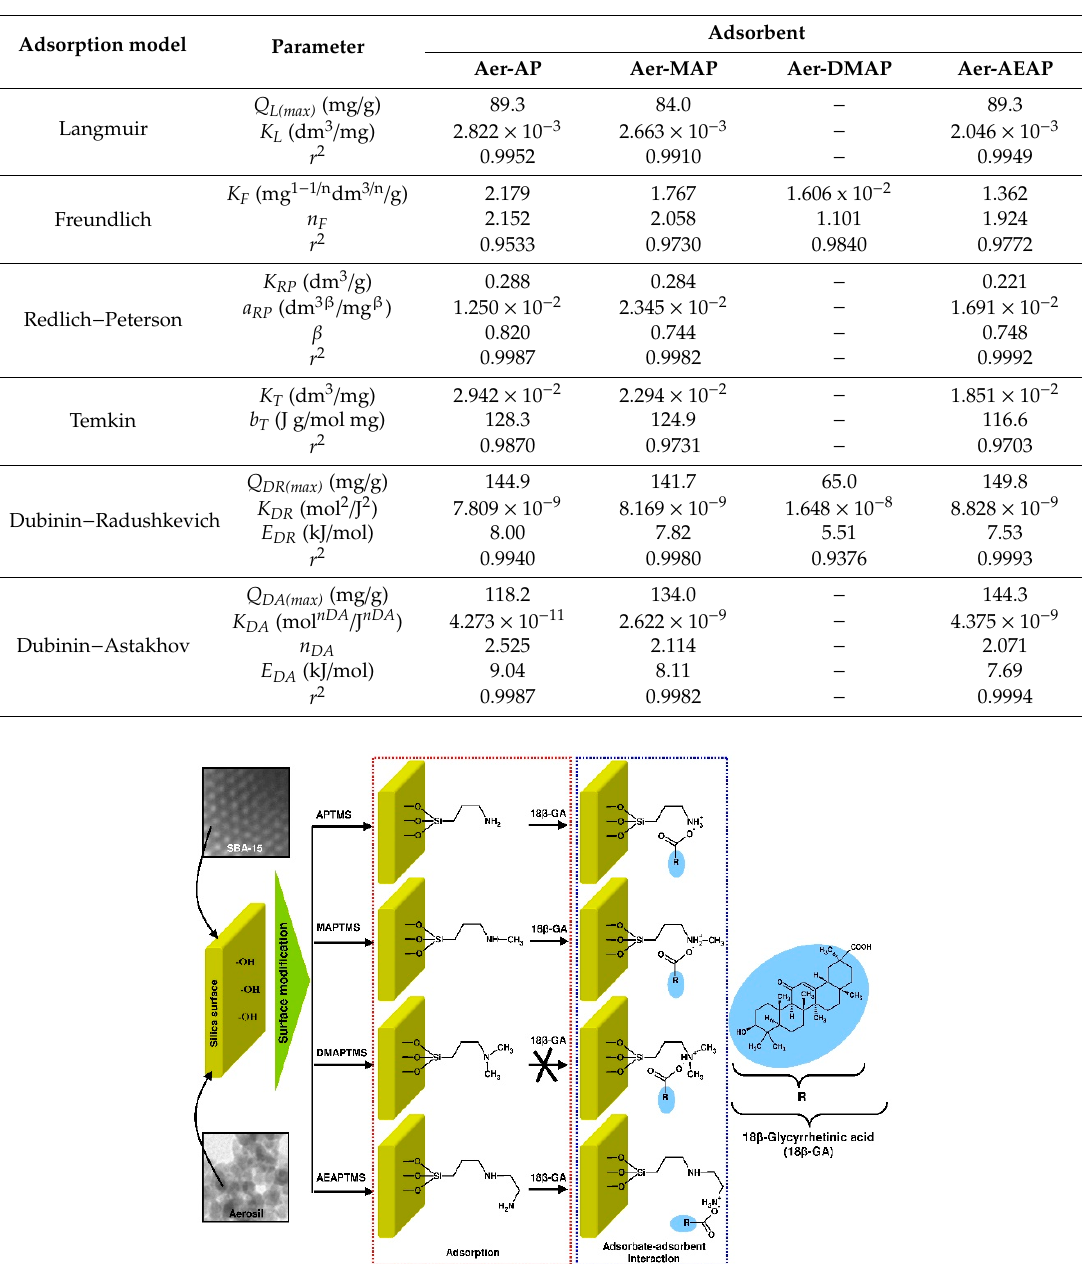
Table 4. Isotherm parameters calculated from linear regression for 18 β -glycyrrhetinic acid adsorption onto non-porous silica functionalized with various amine groups.